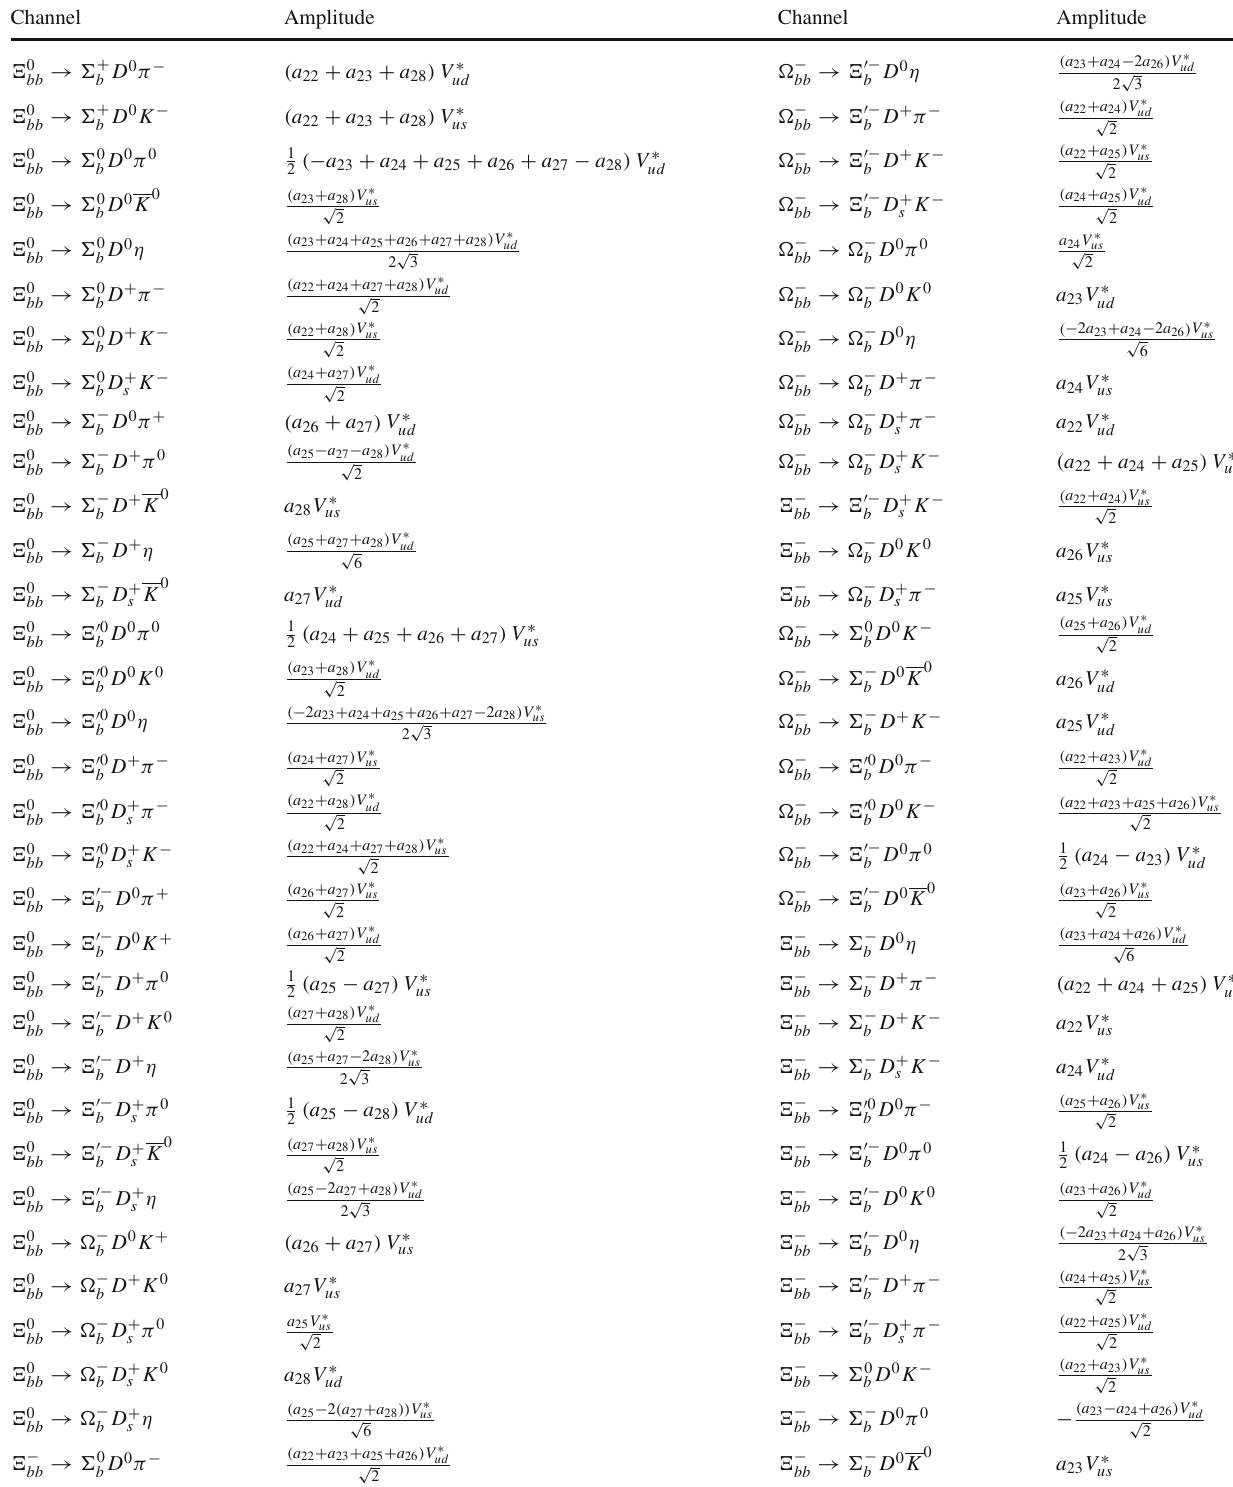
Table 19 Doubly bottom baryon decays into a bqq (sextet), a charmed meson and a light meson Channel Amplitude Channel